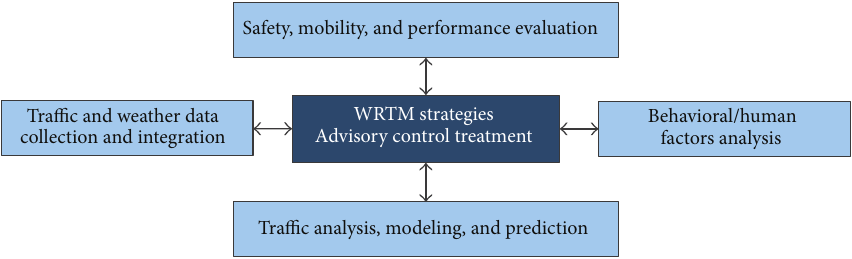
Figure 1: Framework for Weather Responsive Traffic Management (WRTM) Program